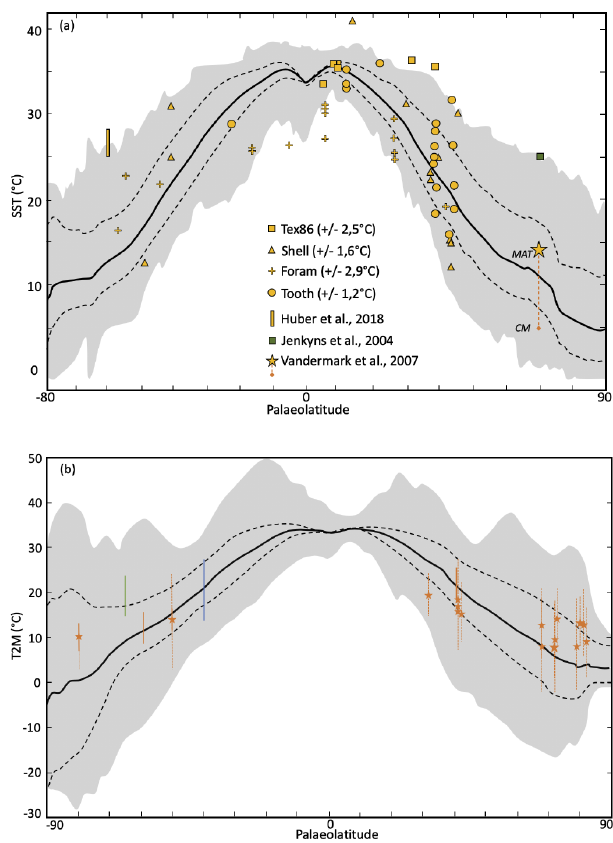
Figure 10. Meridional surface temperature gradients for the 4X- CRETACEOUS simulation. (a) Oceanic temperatures: the solid line corresponds to the mean annual temperature obtained from the mod- elling. Dashed lines correspond to winter and summer seasonal av- erages. The grey shaded areas correspond to local monthly tem- peratures. Data points are obtained with several proxies for the Cenomanian–Turonian Period. The green data point is obtained from TEX86 for the Maastrichtian (70Ma) and extrapolated for 90Ma. The Huber et al. (2018) point is obtained from δ 18 O on foraminifera and the Vandermark et al. (2007) point is interpreted from the presence of crocodilian fossils. MAT: mean annual tem- perature; CM: coldest month. (b) Atmospheric temperatures: same legend as (a) for modelised temperatures. Data points are obtained from several proxies including CLAMP analysis on palaeofloras, leaf analyses, palaeosol-derived climofunction or bioclimatic anal- ysis. Symbols represent mean annual temperatures and solid lines associated ranges/errors. Dashed lines represent monthly mean tem- peratures. Orange data points are for Cenomano–Turonian ages (100–90Ma), blue data points for Albian and green data points for Coniacian–Santonian